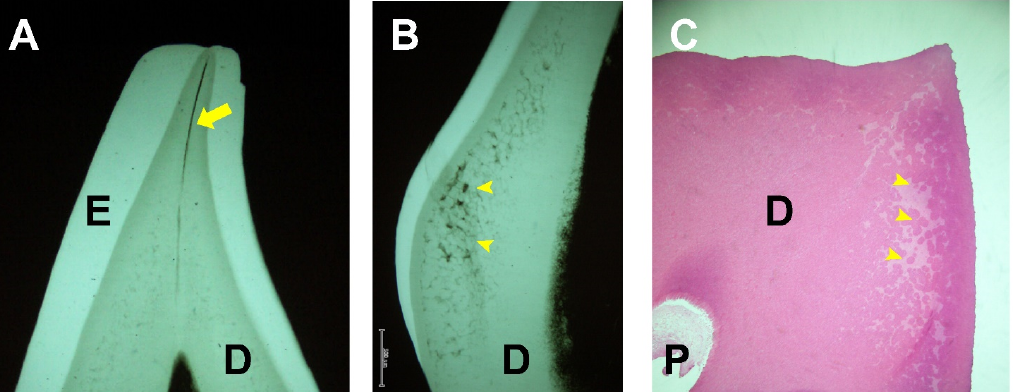
Figure 4. ( A ) Contact microradiograph of a ground section of a primary tooth of a patient with X-linked hypophosphatemia (XLH) showing a tubular defect from the enamel–dentin junction to the pulp (arrow). ( B ) Contact microradiograph of a ground section of a primary tooth of a patient with XLH showing interglobular dentin (arrowheads). ( C ) Histopathological image of a decalcified section of a permanent tooth of a patient with XLH aged 20 years (H-E staining) showing interglobular dentin (arrowheads). E: enamel; D: dentin; P: